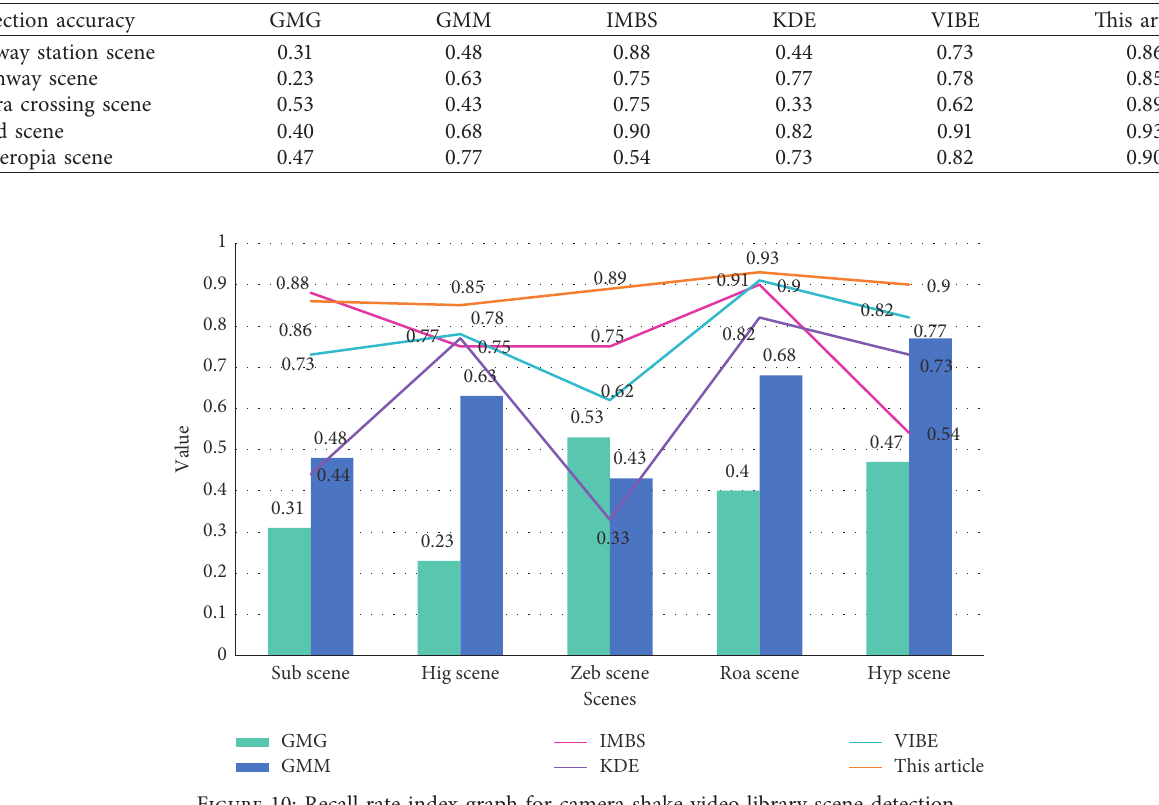
Table 9: Data of recall rate index for camera shake video library scene detection.